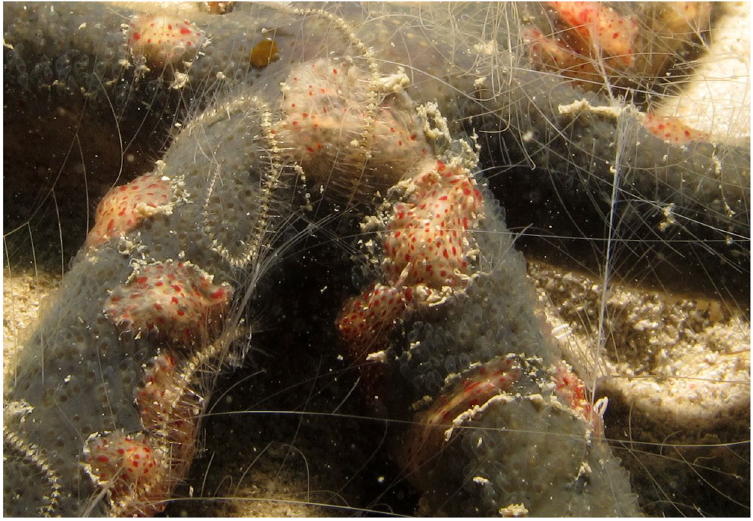
Figure 7. Coeloplana astericola collected from its host, the sea star Echinaster sp., in Tun Mustapha Park, northernmost tip of Borneo, Sulu